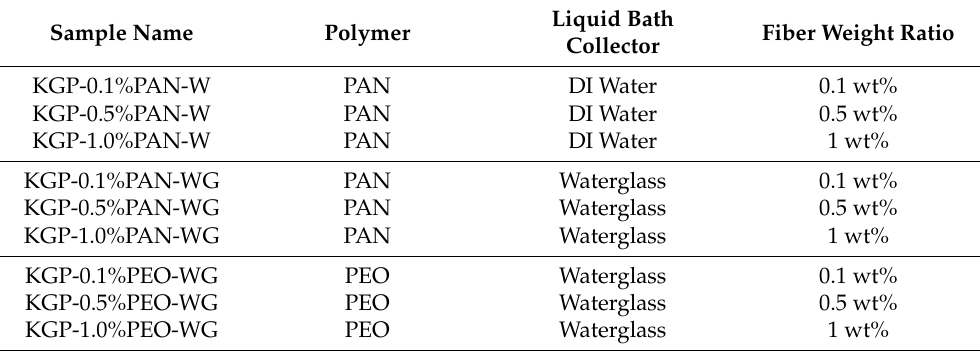
Table 1. Mix design for the geopolymer nanocomposites reinforced with electrospun polyacrylonitrile (PAN) and poly(ethylene oxide) (PEO), that were synthesized in this